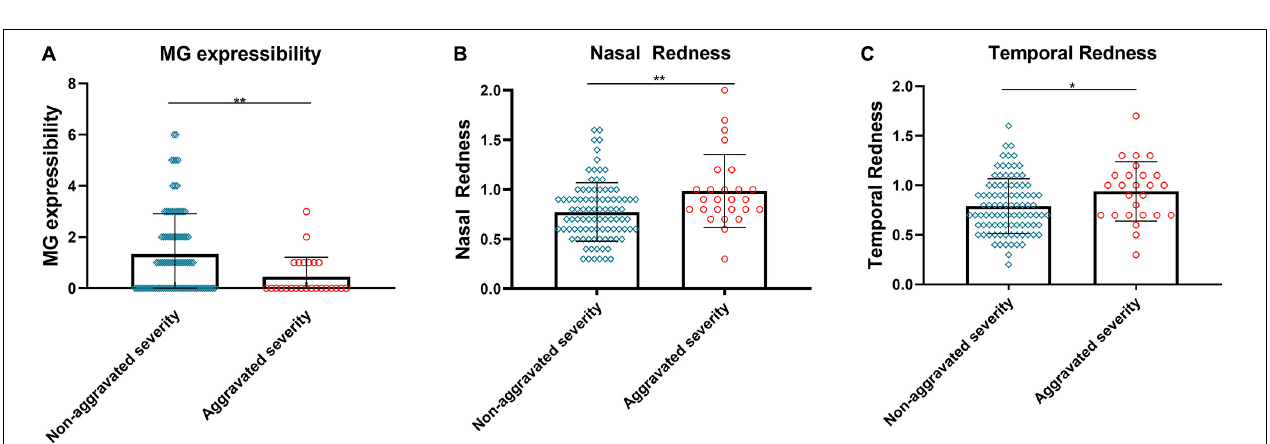
FIGURE 2 | Relationship between changes in severity and baseline MG expressibility and ocular redness. The MG expressibility (A) of aggravated severity subjects before the reading test was significantly lower than those of non-aggravated severity subjects. Evident aggravation was observed in nasal (B) and temporal (C) bulbar conjunctival redness for subjects with aggravated severity. (A–C) Dates are presented as median and interquartile range, * p ≤ 0.05, ** p ≤ 0.01.